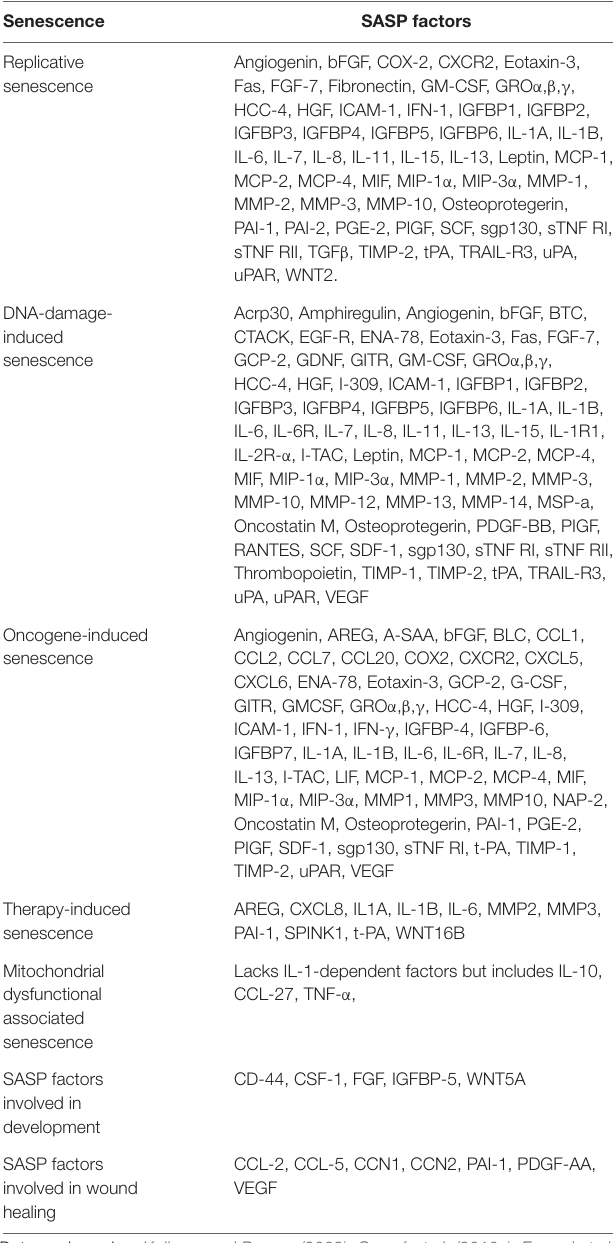
TABLE 1 | Selected list of SASP factors involved in different senescence contexts.